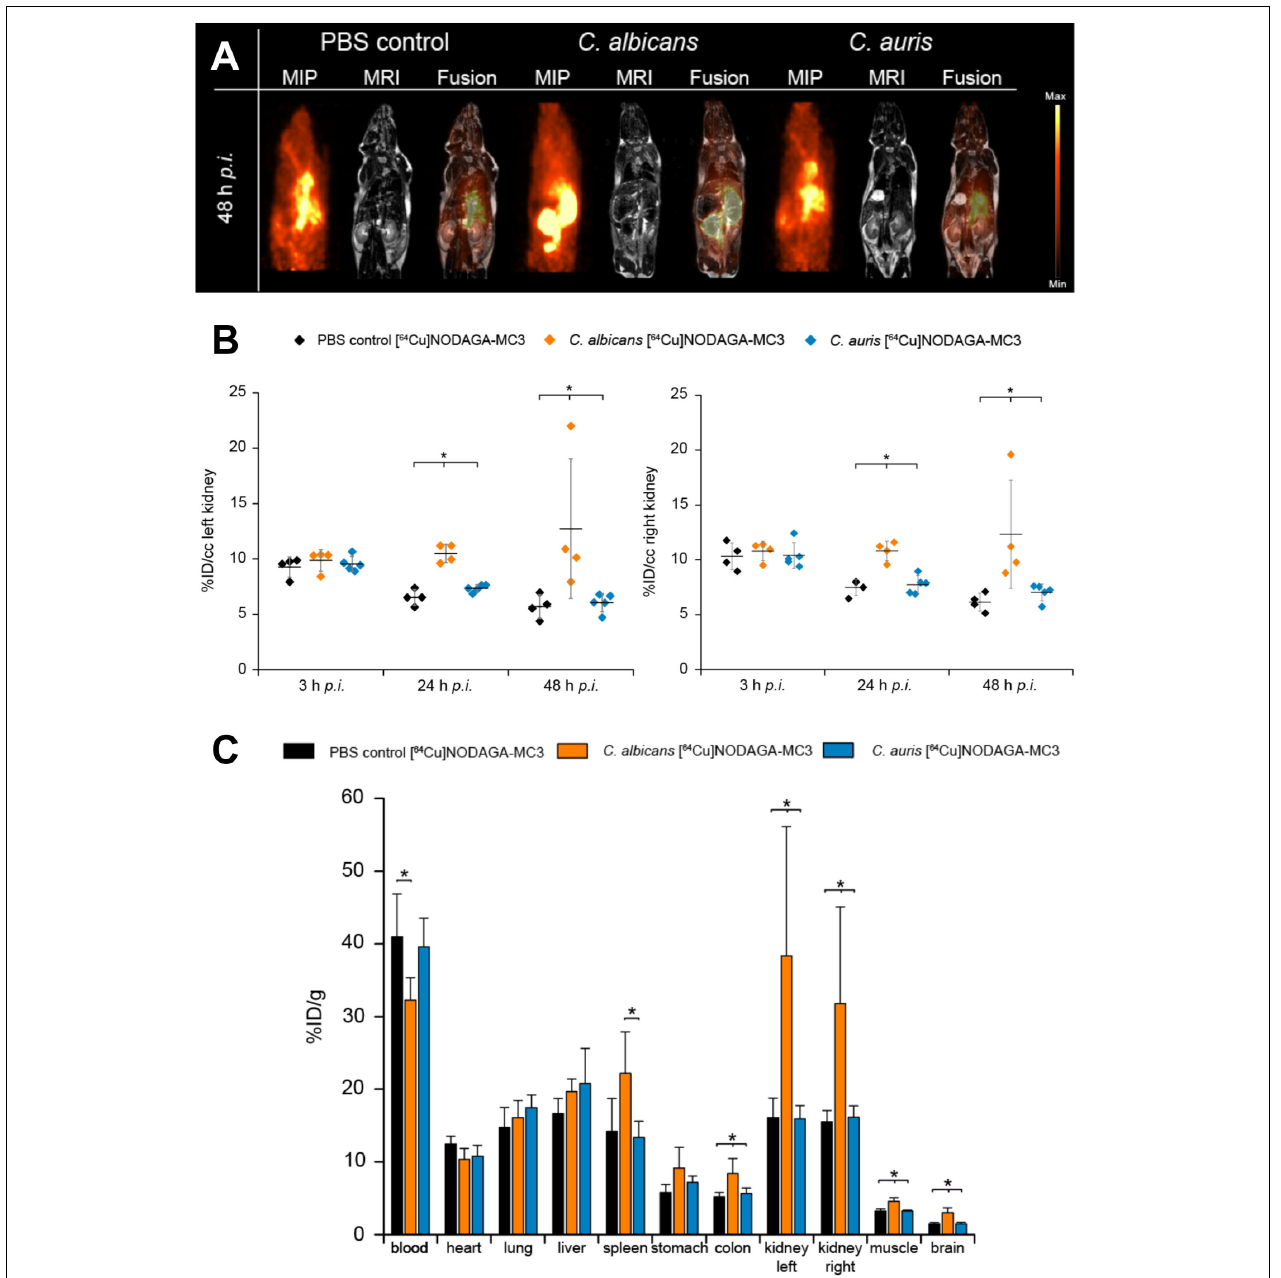
FIGURE 3 | (A) In vivo biodistribution of [ 64 Cu]NODAGA-MC3 in PET/MR imaging at 48 h p.i. Coronal Maximum Intensity Projection (MIP), MR and fused PET/MR images of PBS-treated (control) mice, and C. albicans -infected and C. auris -infected mice injected with the tracer. The acquired images reveal specific uptake of the tracer in the left and right kidneys of C. albicans -infected mice, but not in the kidneys of PBS-treated (control) mice. The specificity of the tracer was further demonstrated using a strain of C. auris which, while reactive with MC3 in vitro using ELISA ( Figure 1 ), was non-infective in the i.v. challenge model. Here, uptake of the tracer in the kidneys was similar to the uptake found in the PBS control mice. (B) Quantification of the PET images for the left and right kidneys of the three different groups of mice at 3, 24, and 48 h p.i. Significantly higher uptake of the [ 64 Cu]NODAGA-MC3 tracer is seen in the left and right kidneys of C. albicans -infected mice compared to PBS-treated (control) and C. auris -infected animals at 24 and 48 h p.i. Data are expressed as mean ± SD %ID/cc. Group differences were examined using one-way ANOVA, followed by post hoc Tukey–Kramer, with significant differences at ∗ p < 0.05. (C) Ex vivo biodistribution at 48 h p.i. Significantly higher uptake of the [ 64 Cu]NODAGA-MC3 tracer in the left and right kidneys of C. albicans -infected mice, compared to the kidneys of corresponding PBS-treated (control) and C. auris -infected animals, confirms the PET/MR imaging and in vivo biodistribution data at 48 h p.i. In addition to increased uptake of the tracer in the kidneys, significantly higher uptake was also shown in the colons, muscles, and brains of C. albicans -infected mice compared to C. auris -infected and PBS-treated mice, significantly higher uptake in the spleens of C. albicans -infected mice compared to C. auris -infected mice, but significantly reduced uptake in the blood of C. albicans -infected mice compared to PBS-treated (control) animals. Data are the results of N = 4–5 animals per group and expressed as the mean ± SD %ID/g.